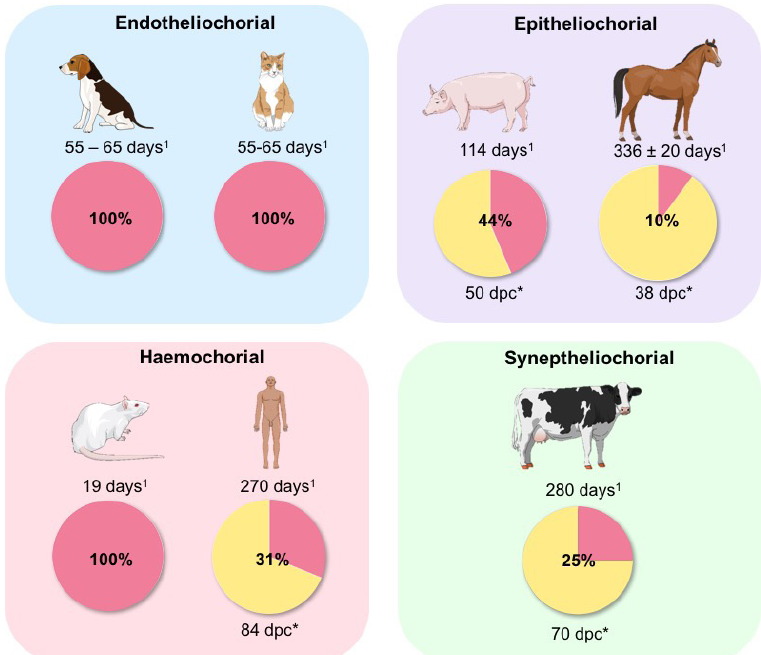
Figure 1. Yolk sac (YS) development and function compared in different species. 1 gestation time (in days); *YS regression; %: persistence of YS during pregnancy; dpc: days post